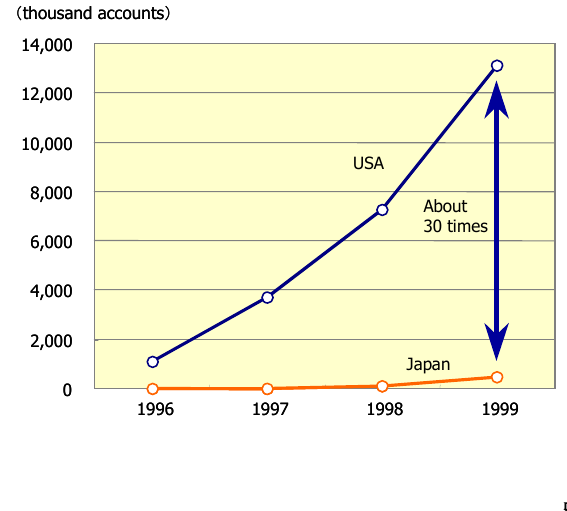
Figure 3. Increase of Online Securities Accounts in USA &